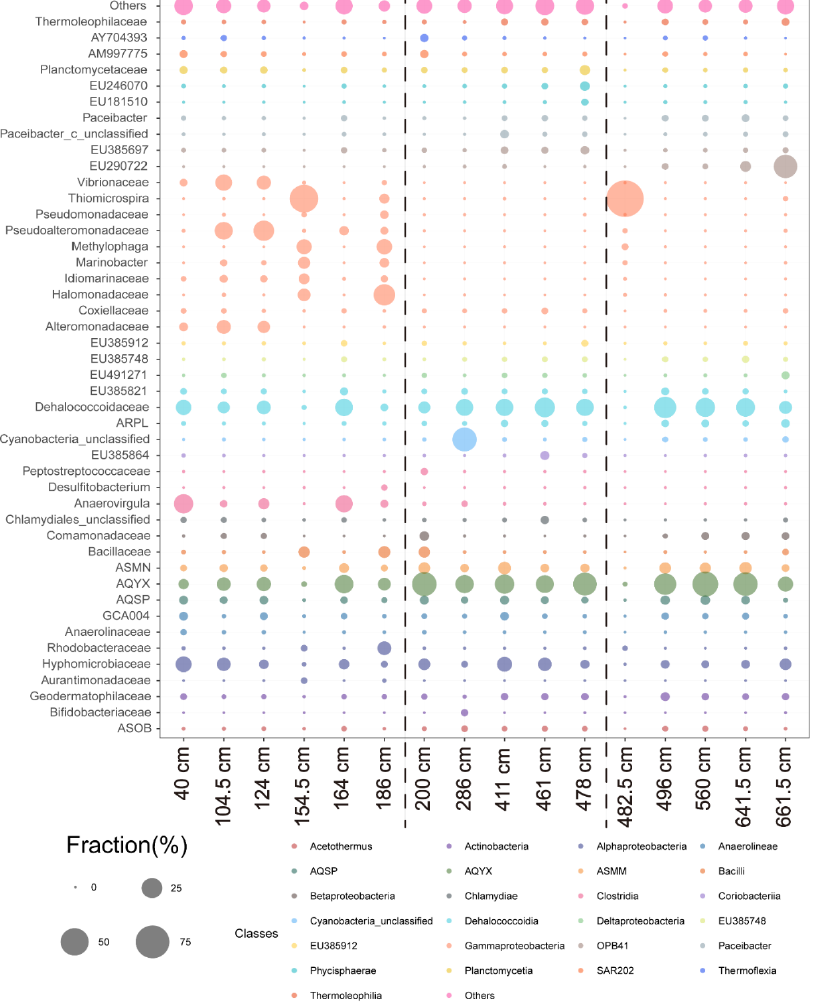
Figure 7. Relative Bacterial Abundance at the Family Level. The vertical and horizontal axes represent the taxonomic family and the name of the samples, respectively. The colors of the circles in the chart represent the name of the taxonomic classes. The size of the circle shows the number of microorganisms in the Family and Class. The Family and the Class not marked with a scientific name represent unidentified organisms. The samples at 40, 104.5, 124, 154.5 (U-Oki), 164, and 186 cm (TL-1) represent the interglacial period, while at 200, 286, 411, 461, and 478 (CaM) cm, they represent the late glacial period. The sample at 482.5, 496, 560, 641.5, and 661.5 cm represent the glacial period.